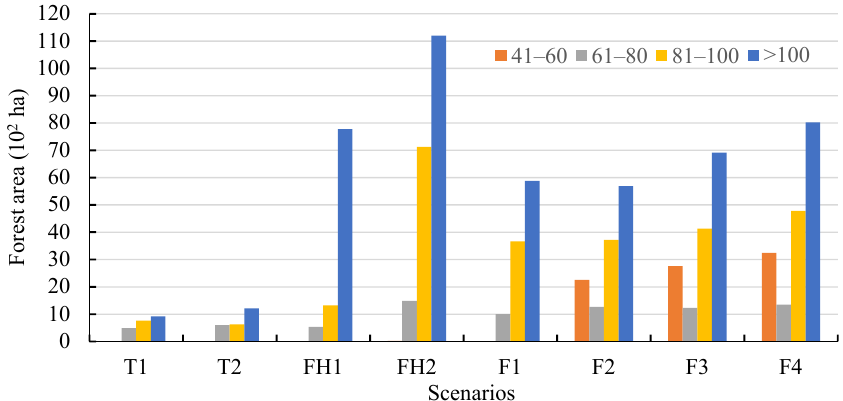
Figure 3. Distribution of forest areas that were not assigned to any management treatment by potential age classes (years) at Maoershan Forest Farm, China, over a 50-year planning horizon of alternative management strategies: timber-oriented management strategy (TMS, scenarios T1 and T2), fixed selection of suitable habitat management strategy (FSSHMS, scenarios FH1 and FH2), and free selection of restricted suitable habitat management strategy (FSRSHMS, scenarios F1 to F4).